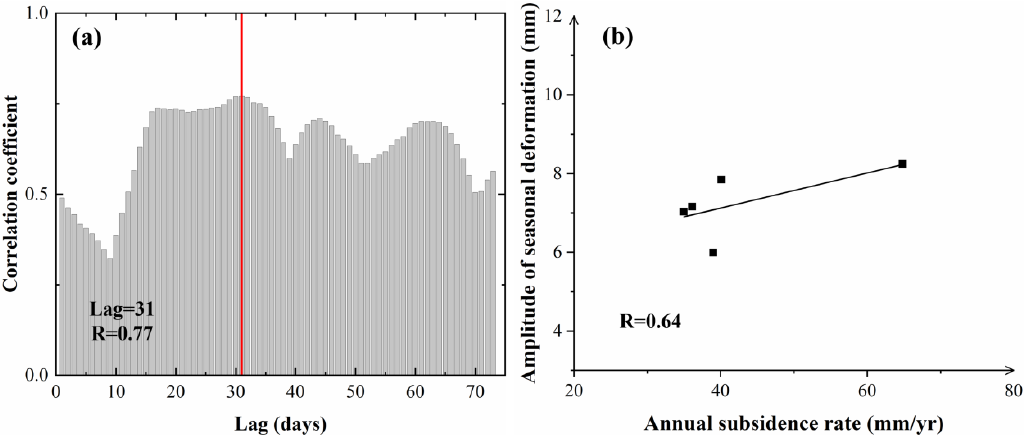
Figure 6. ( a ) Correlation analysis between the de-trend displacement and the de-trend head time series at observation well D117. The red line marks the highest correlation coefficient. ( b ) Comparison between annual subsidence rate and amplitude seasonal deformation.